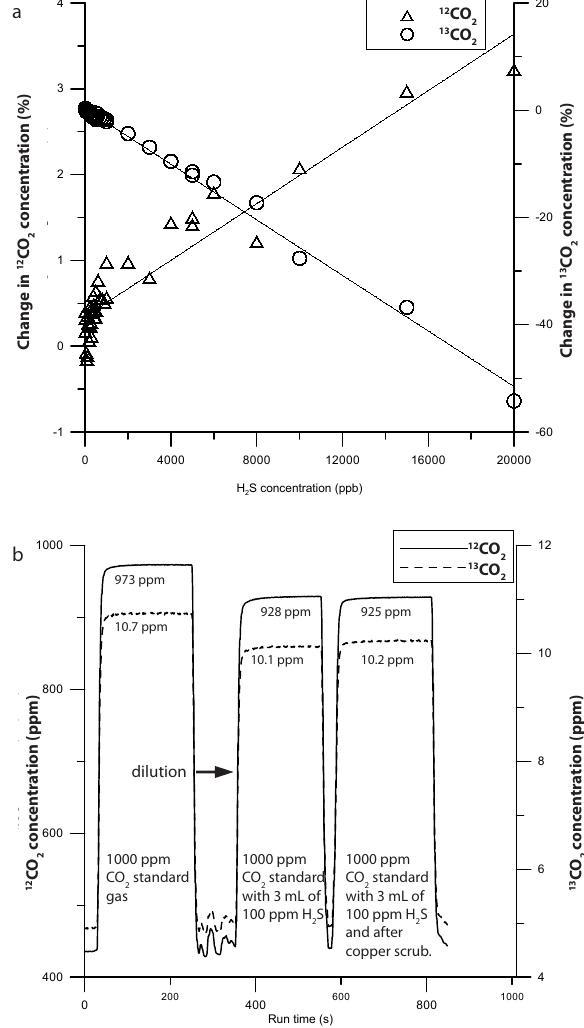
Figure 3. Change in the 12 CO 2 and 13 CO 2 concentrations with ad- dition of H 2 S to the standard gas. (a) Plot showing the percent- age change in CO 2 concentration between gas with H 2 S and gas scrubbed of H 2 S. There is a visible increase in the 12 CO 2 con- centration and a decrease in the 13 CO 2 concentration with addi- tion of H 2 S. The percentage decrease for 13 CO 2 is significantly greater than the percentage increase for 12 CO 2 . (b) Plot showing the 1000ppm standard CO 2 gas with the addition of 3mL of 100ppm H 2 S and the subsequent response after the H 2 S was removed with the copper scrub. There is a small, yet visible, increase in the 13 CO 2 concentration and decrease in the 12 CO 2 concentration when H 2 S is